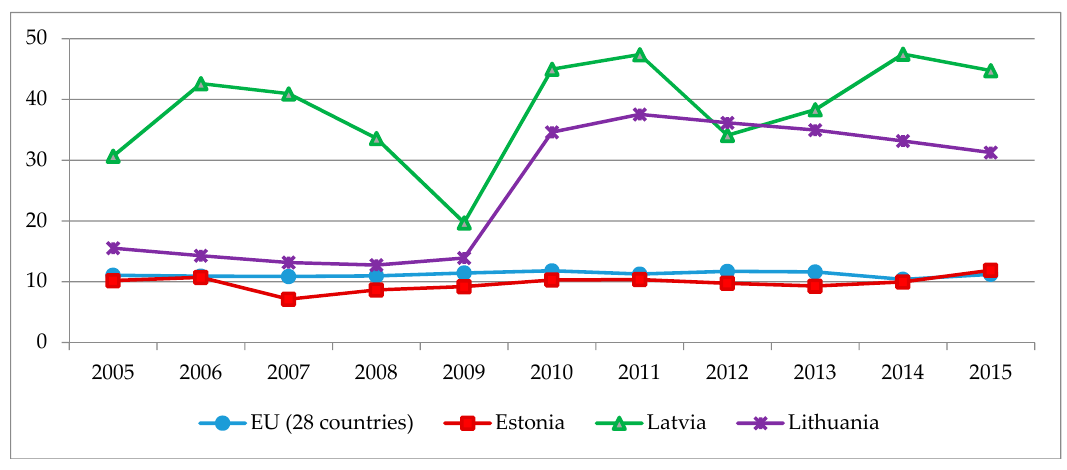
Figure 11. Combined heat and power generation as a percentage of gross electricity generation.